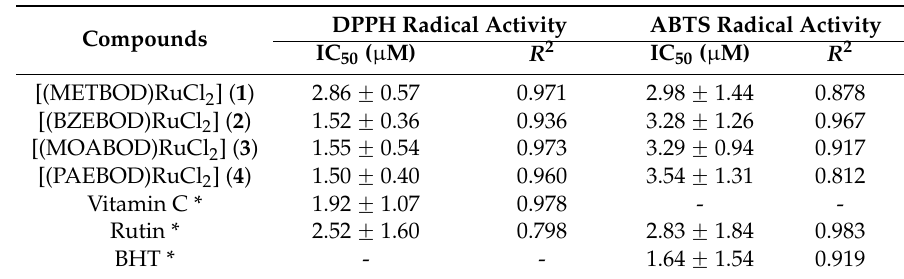
Table 1. The IC 50 values of DPPH- and ABTS-scavenging activity of heterocyclic Ru(III) complexes compared to a standard anti-oxidant drug.